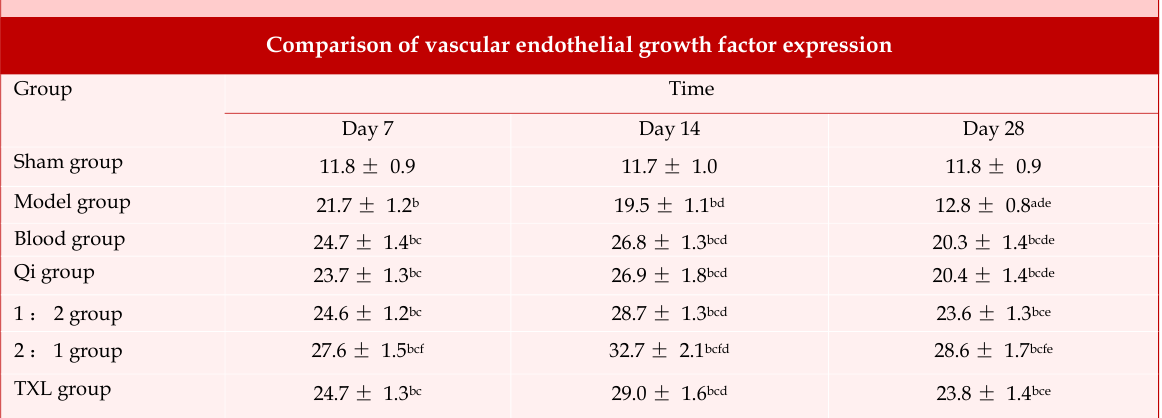
Comparison of vascular endothelial growth factor expression